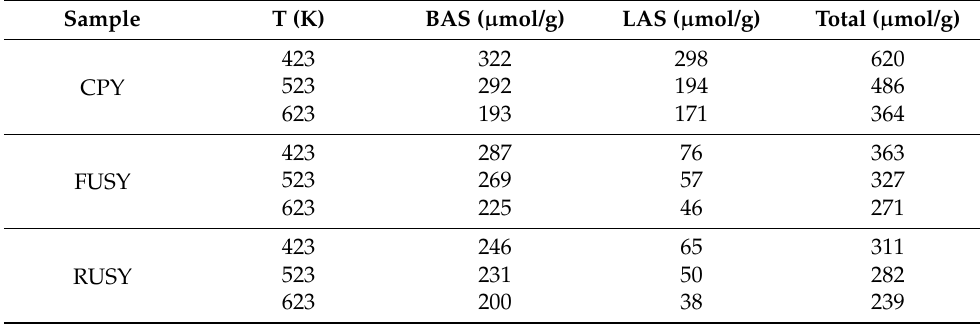
Table 2. Pyridine FTIR data on the three Y-zeolite